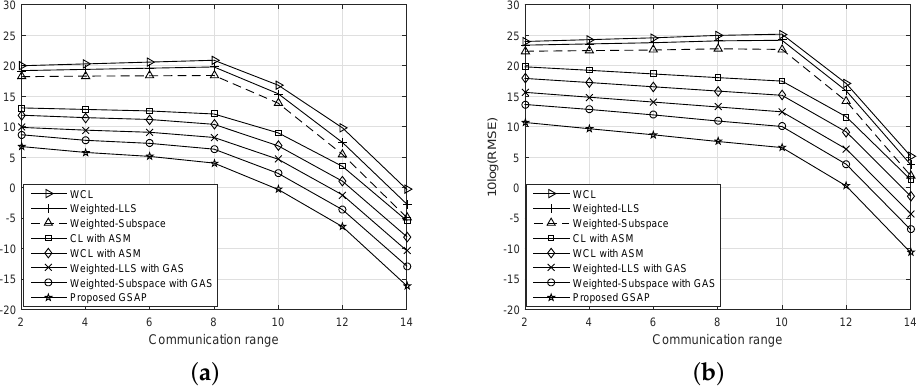
Figure 5. RMSE performance vs. communication range, R. ( a ) AMs uniformly distributed over the whole area; ( b ) AMs distributed uniformly in the lower left